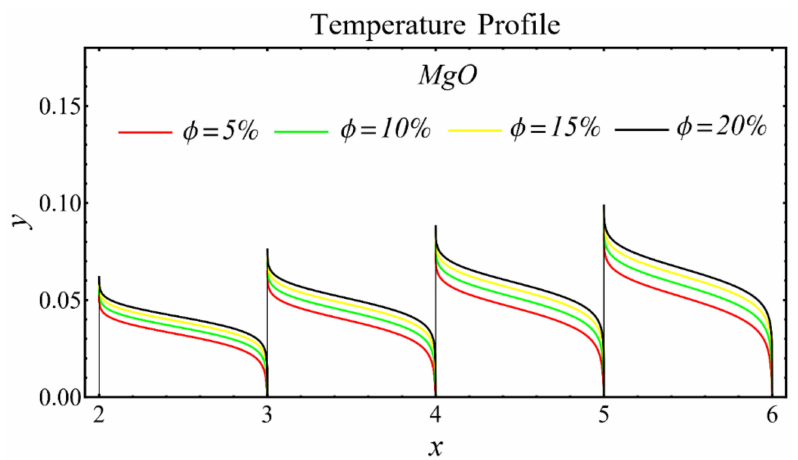
Figure 14. Temperature profile of MgO-EG nanofluid under influence of nanoparticle concentration.